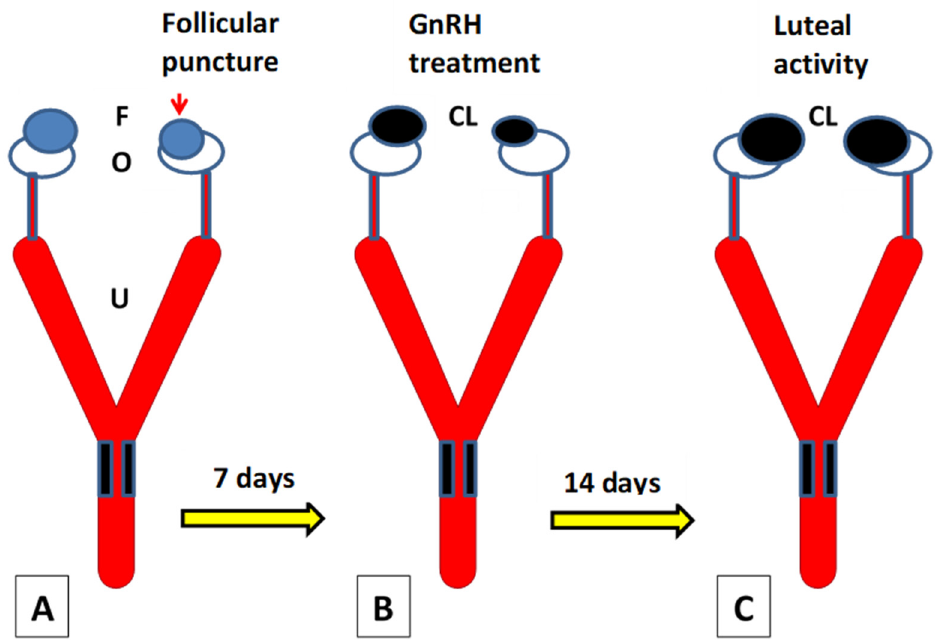
Figure 2. Puncture and drainage of the smaller co-dominant follicle at the time of insemination in cows with a follicle of pre-ovulatory size in each ovary ( A ). GnRH treatment is given seven days post-drainage to reinforce luteal activity of the drainage-induced luteal tissue ( B ). Luteal activity determinations are made 21 days post-drainage ( C ). Both corpora lutea are not distinguishable at this time point [65]. F: follicles; CL: corpora lutea; O: ovaries; U: uterus.